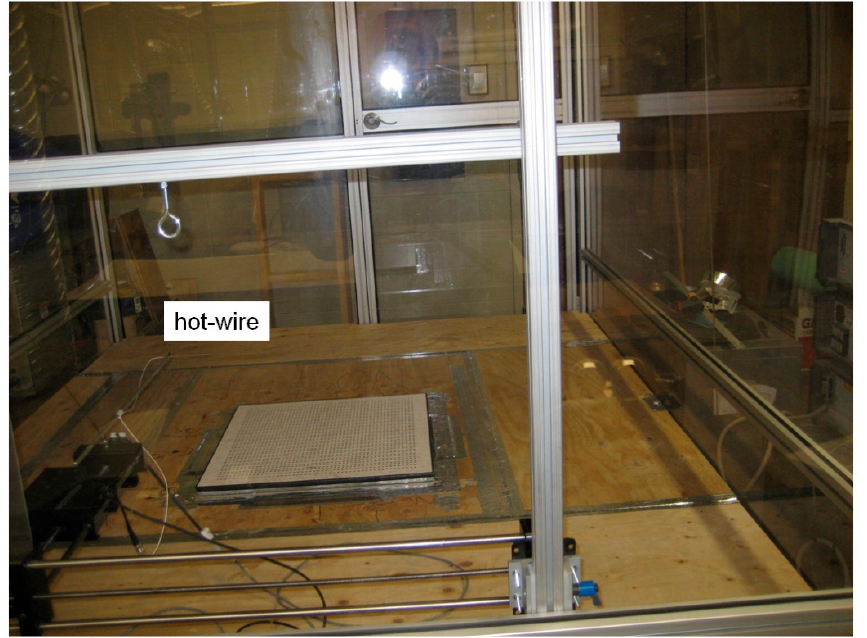
Figure 1. Air velocity measurement for an isolated tile in a small chamber (Reprinted with permission from [Abdelmaksoud, W.A.], [Ph.D. Thesis]; published by [Syracuse University], [2012]).